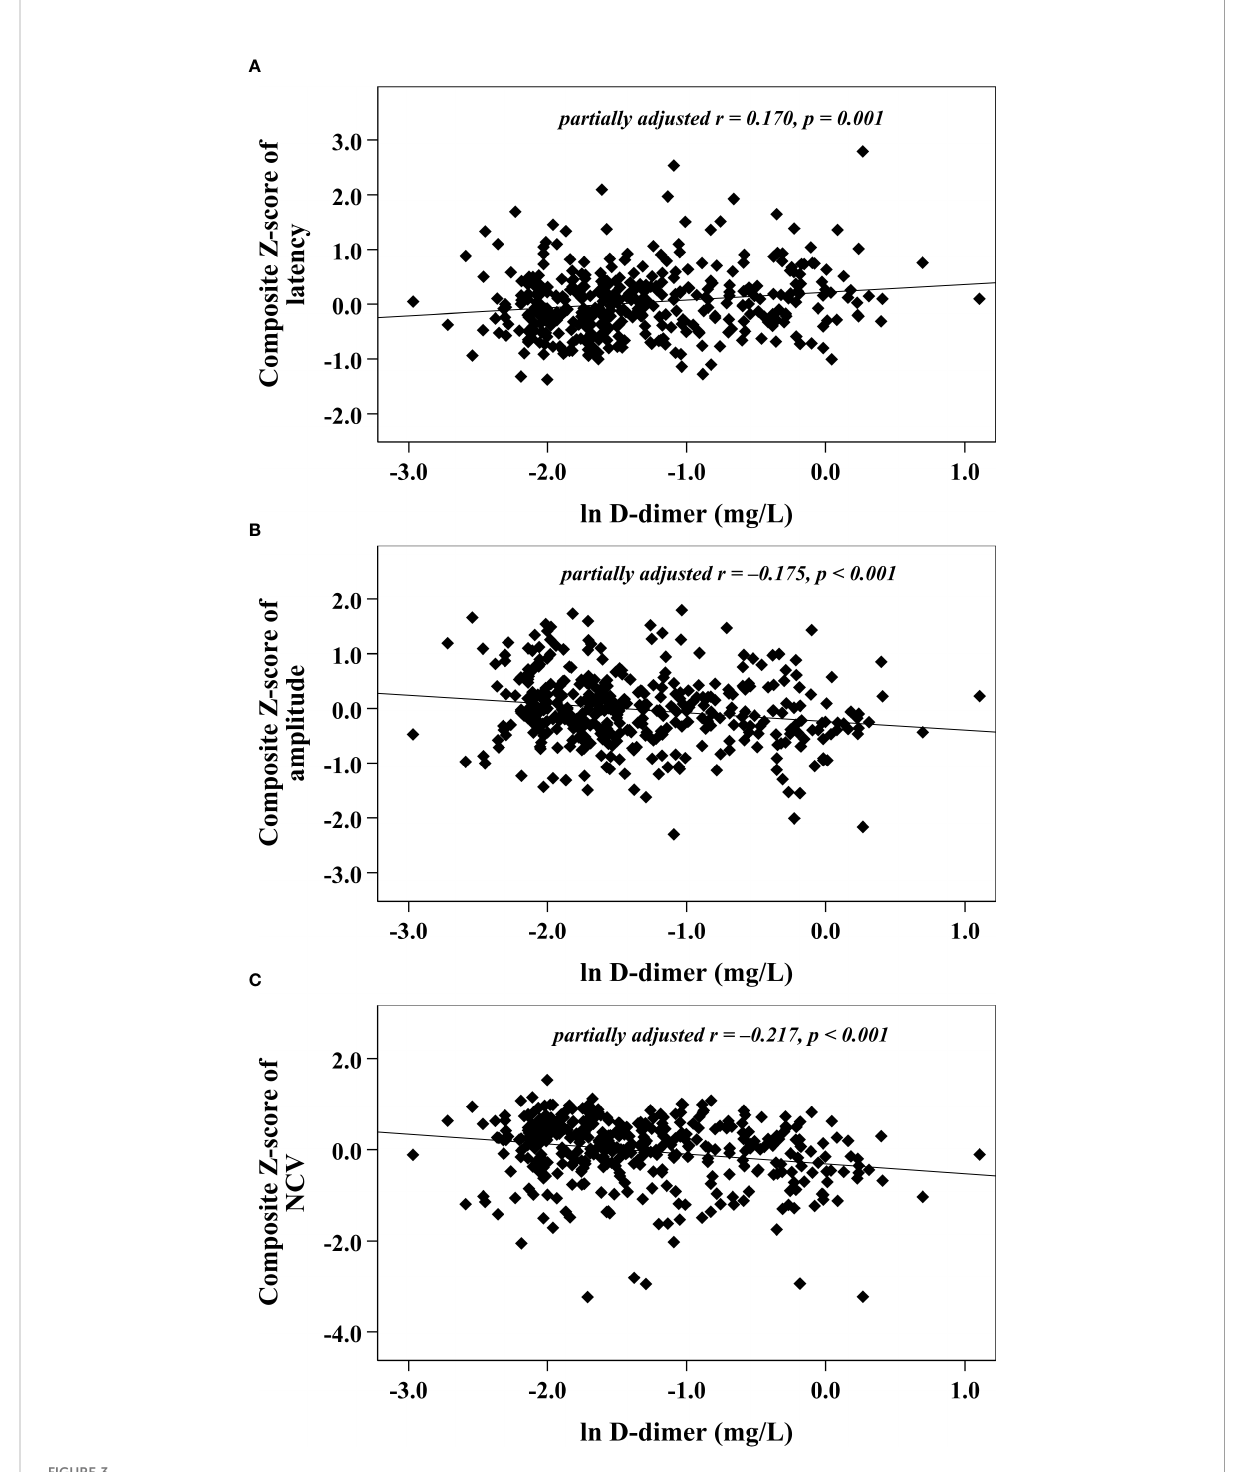
FIGURE 3 Graphically exhibited correlations between D-dimer and nerve conduction indices after adjusting for fi brinogen ( A: composite Z score of latency; B: composite Z score of amplitude; C: composite Z score of